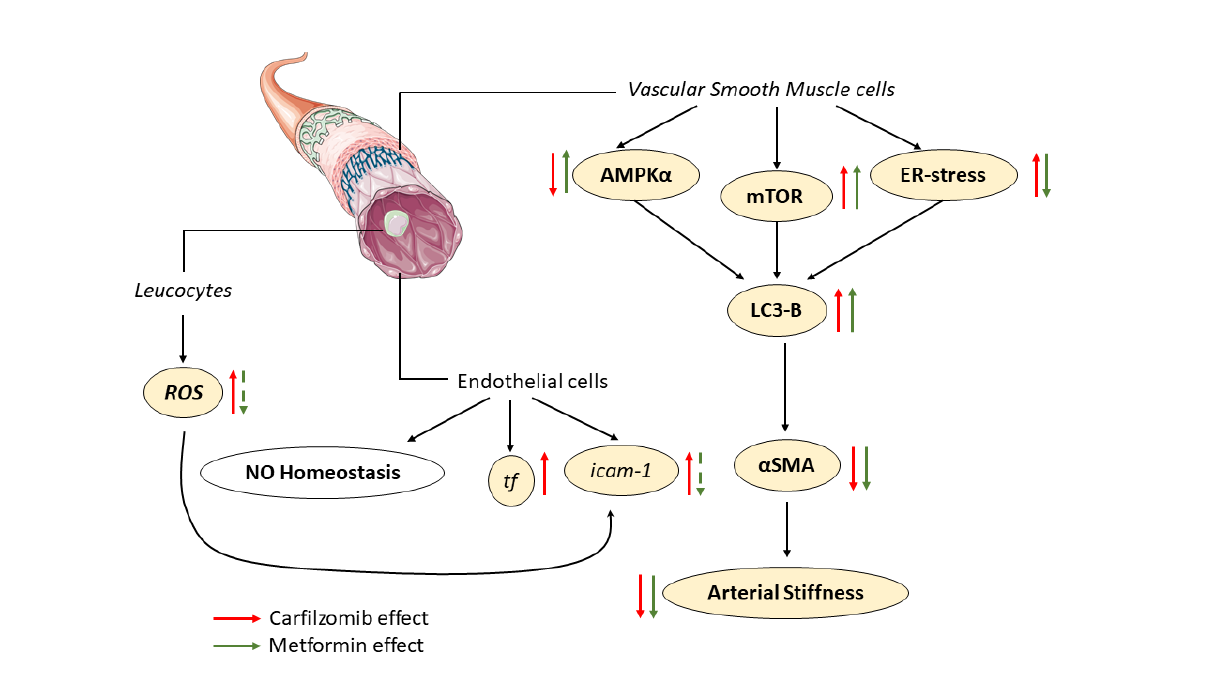
Figure 9. Schematic representation of the e ff ect of carfilzomib and metformin coadministration on the vessels. White panels represent independent molecular targets, red arrows indicate Cfz-dependent pathways, green arrows represent Met-dependent pathways. Cfz, carfilzomib; Met,